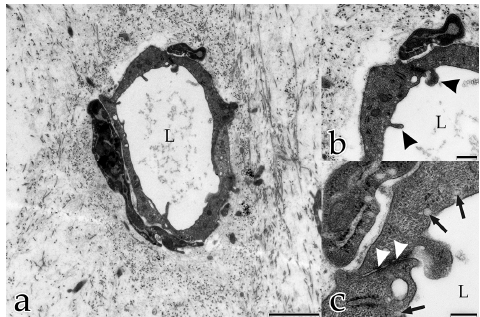
Figure 3. Coculture of ECs with FBs after 20 days: ( a – c ) cross section of a tube embedded in a densely organized ECM. Note the lumen (L); ( b ) magnification of ( a ) EC luminal surface with finger-like filopodia (arrowheads); ( c ) magnification of ( b ) tubular ECs overlap each other; they are connected by tight junctions (white arrowheads). Small vesicles and caveolae mirror pino- and exocytotic activities (arrows). ( a ) Bar: 2.500 nm; ( b ) Bar: 500 nm; ( c ) Bar: 250 nm.